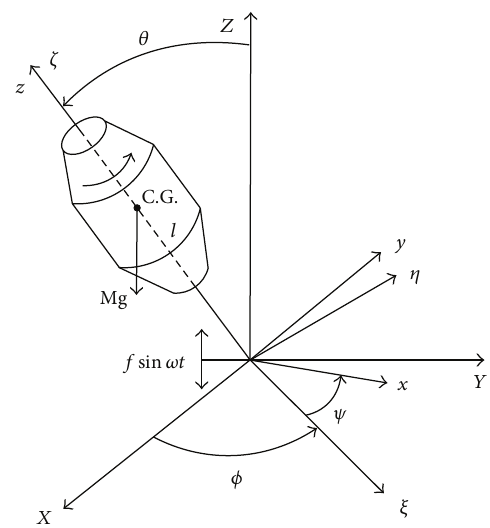
Figure 4: Schematic diagram of a symmetric gyroscope